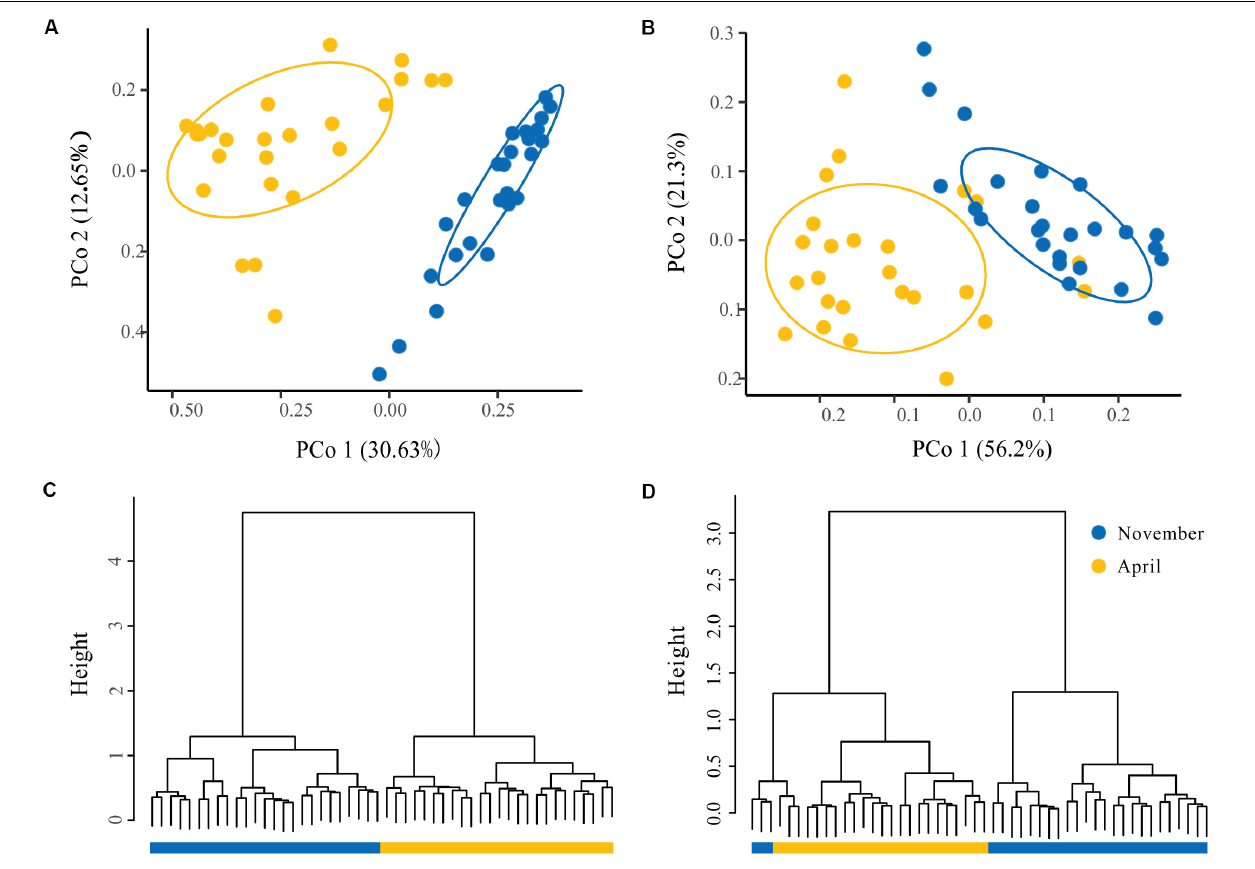
FIGURE 4 | The spatial and temporal patterns in the structure of bacterioplankton taxa and function. Principal coordinates analysis (PCoA) of the bacterioplankton taxa (A) and function (B) derived from the Bray–Curtis dissimilarity matrix. Hierarchical clustering of samples based on the bacterioplankton community profiles at the OTU level (C) and function (D) . The ovals denote the 95% confidence ellipse. TABLE 1 | Quantitative effects of seasons, latitude, and offshore distances on variation in community structure (taxonomic and functional) using non-parametric permutational multivariate analysis of variance (PERMANOVA). Taxonomic structure Functional